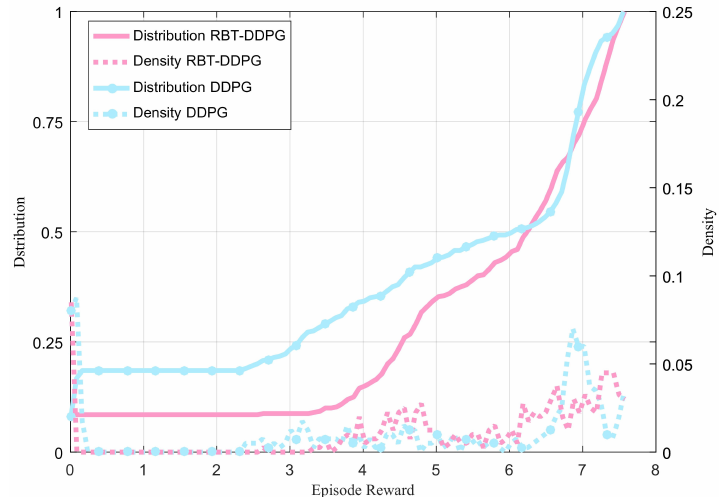
Figure 7. Probability distribution and density of the cumulative reward for each episode in the Monte Carlo test. About 10% of the RBT-DDPG rewards are less than 3, compared to about 24% of DDPG reflecting the greater adaptability of the RBT-DDPG AN to complex initial conditions.